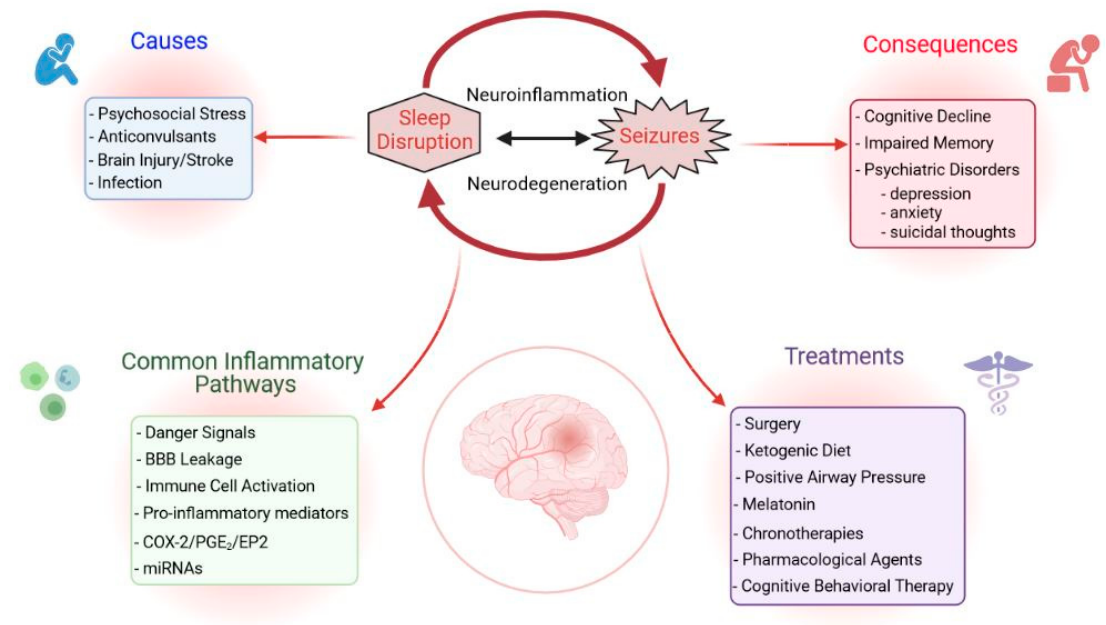
Figure 2. Neuroinflammation as a potential link in the vicious cycle of sleep and epilepsy. This figure was created with BioRender.com.